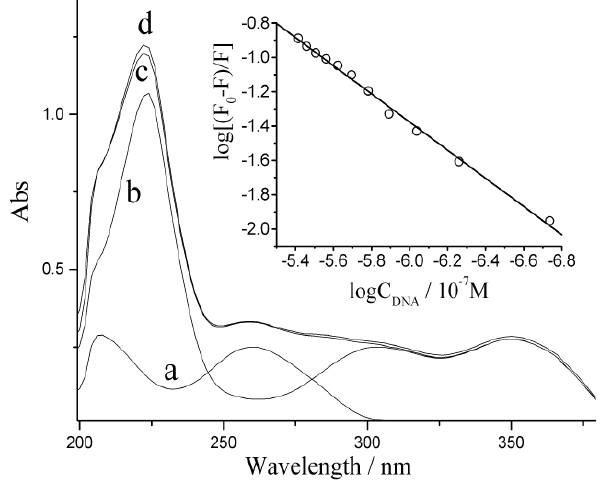
Figure 6. The UV-Vis absorption spectra of (a) 1.1 × 10 − 7 mol L − 1 dsDNA, (b) 4.0 × 10 − 5 mol L − 1 luminol, (c) the mixture of a and b and (d) overlapped